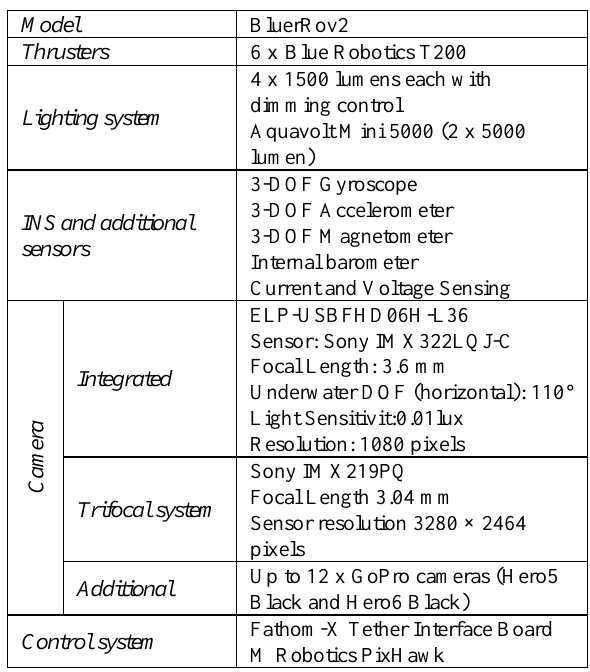
Table 1. Main characteristics of the modified version of the